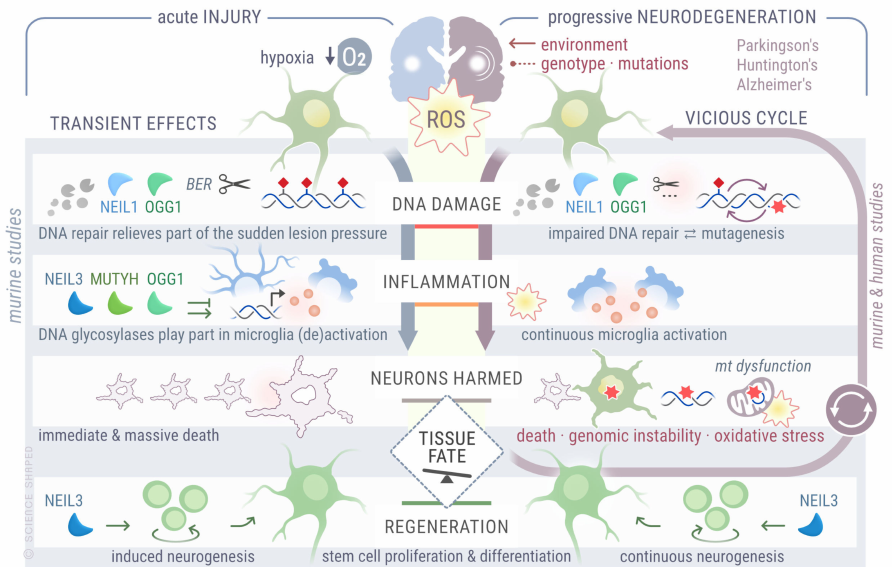
Figure 3. Overview of detrimental effects caused by increased oxidative stress upon hypoxia and dur- ing progressive degeneration, roles of DNA glycosylases in processing resulting oxidized products, and outcomes related to DNA damage repair, inflammation, and tissue